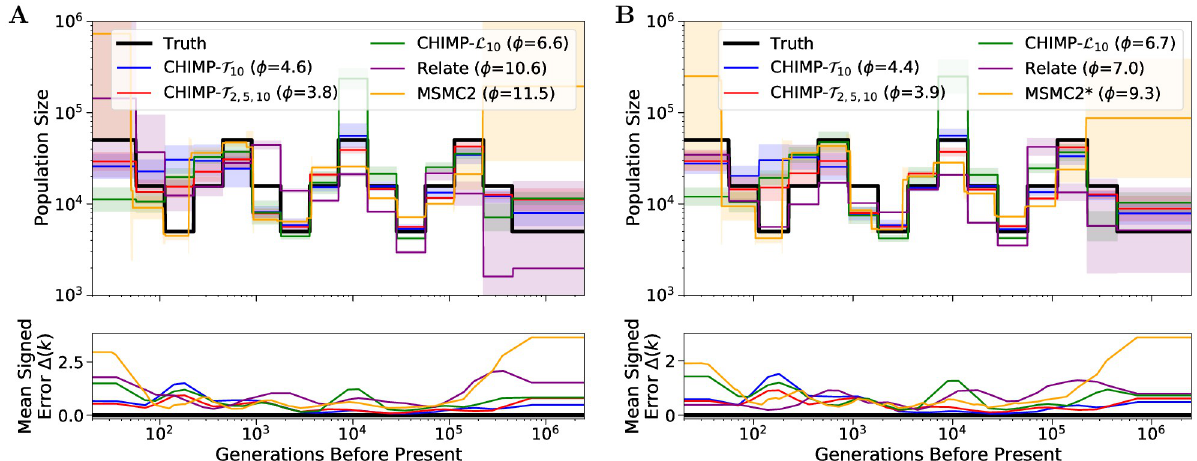
Fig 7. Results of inference in the piecewise sawtooth scenario for sample size 10 (Panel A) and 200 (Panel B). We compare the results using CHIMP , MSMC2 , and Relate to infer the population sizes in the intervals, fixing the change points to match the truth (shown in black). Solid lines are averages over 16 replicates and the standard deviation is indicated by the shaded areas. Mean signed error Δ ( k ) is shown in bottom plot and has been smoothed using moving average for visualization purposes. The integral ϕ is indicated in the legend. Note that MSMC2 groups epochs in the very distant past due to limits of the method interface. ( � ) For sample size 200, MSMC2 was run on 50 non-overlapping pairs.